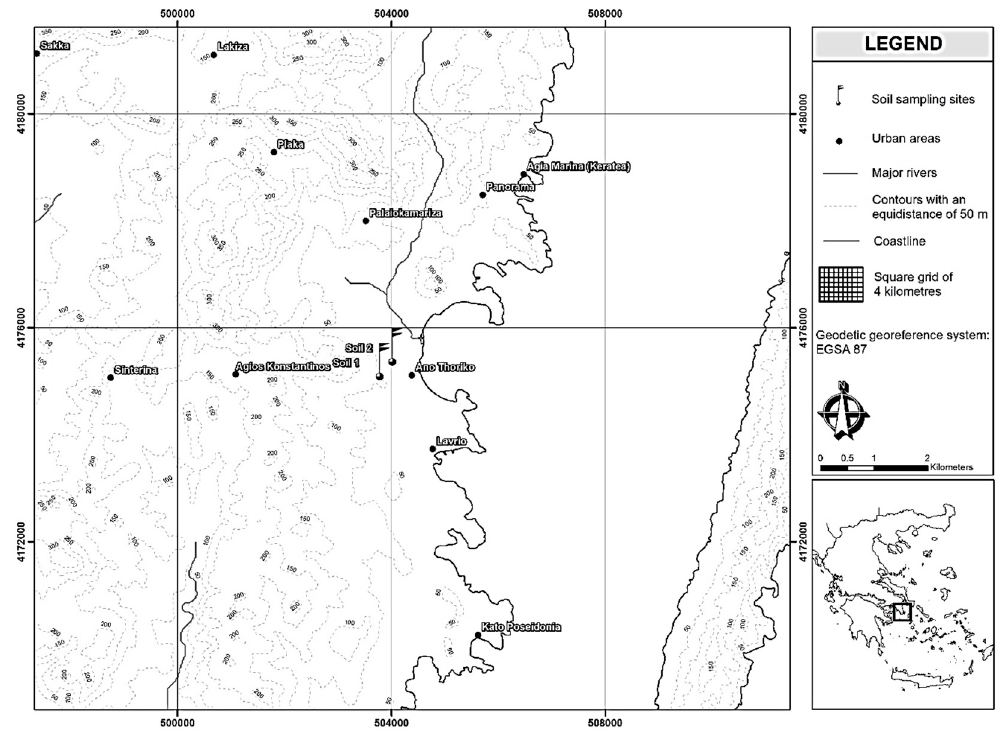
Figure 1. Sampling area—sampling sites. WGS84 coordinates (Latitude/Longitude): 37,7281/24,0446 and 37,7306/24,0473 for soils 1 and 2 respectively.